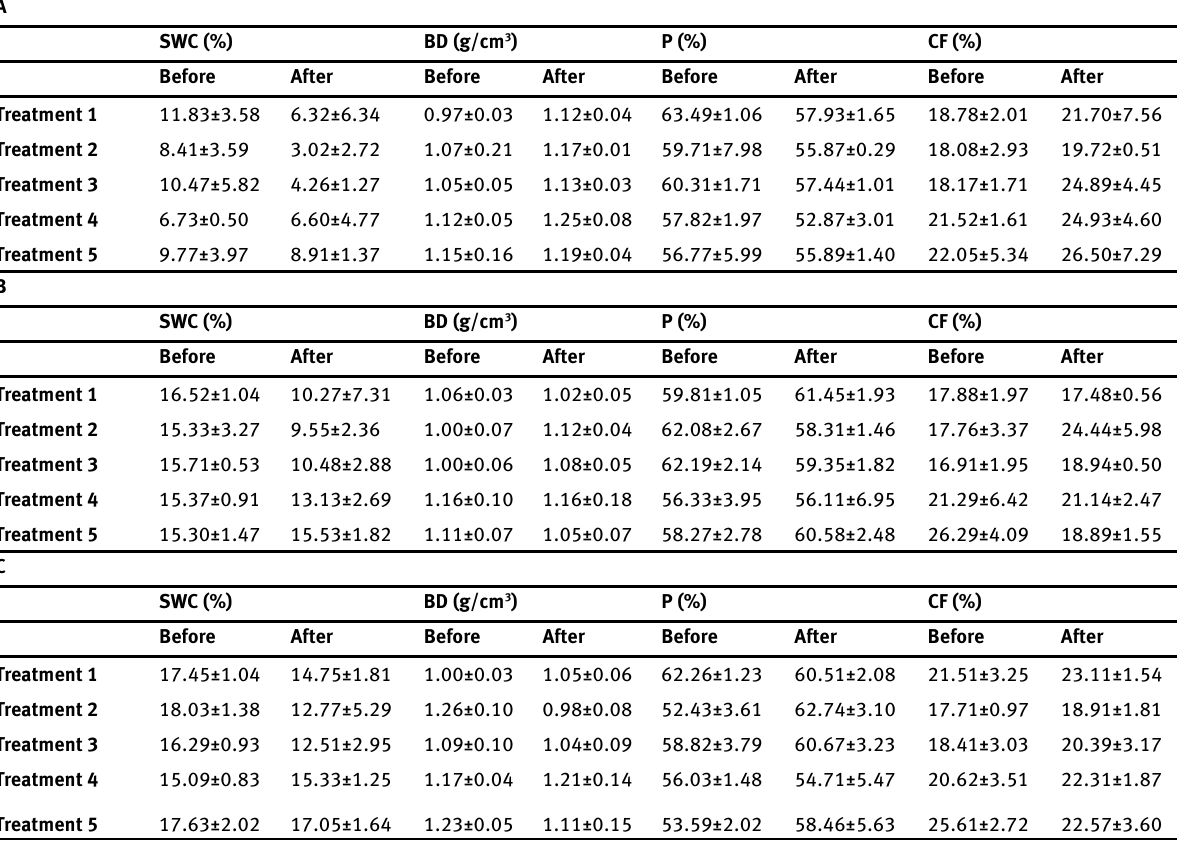
Table 1: Comparison of treatments mean (± standard deviation) of the soil physical properties studied, before and after tillage operations, by